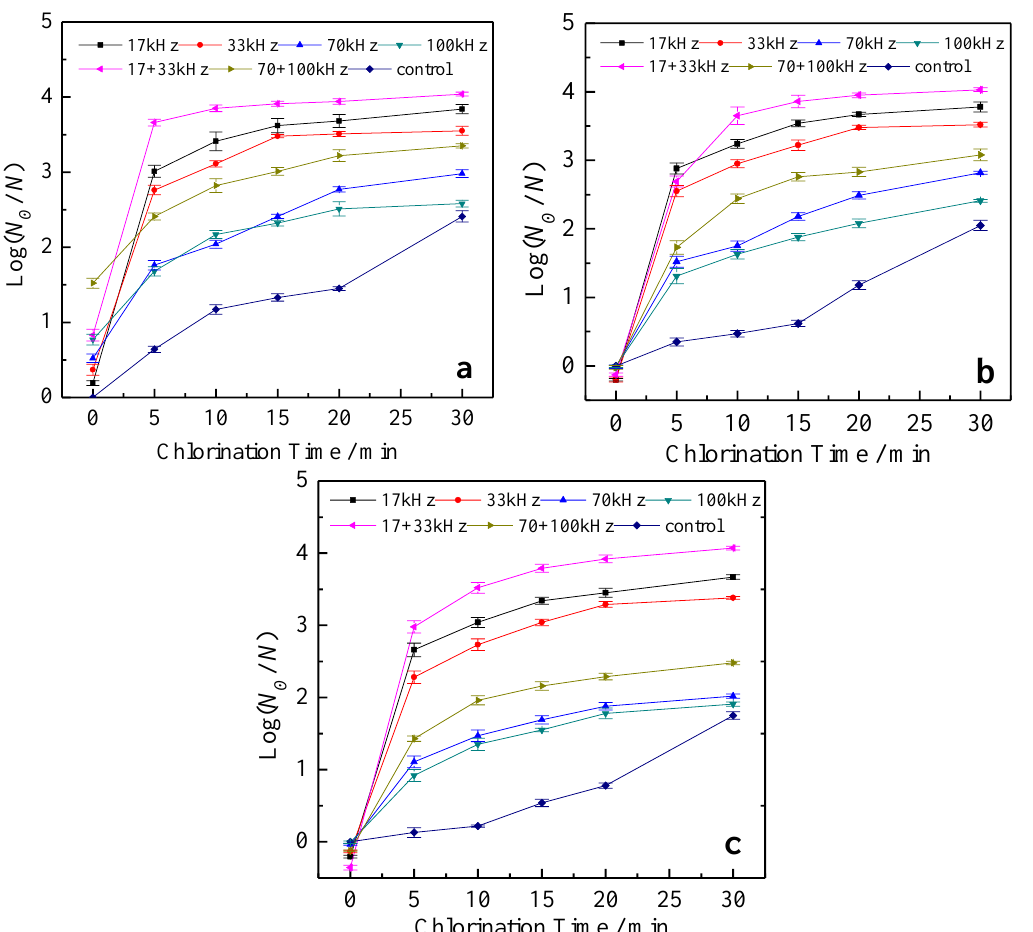
Figure 3. Log inactivation ratio with US pretreatment and 8 mg/L NaClO disinfection under different frequencies: ( a ) E. coli , ( b ) S. aureus , and ( c ) B. subtilis . Error bars correspond to standard error of three replicate